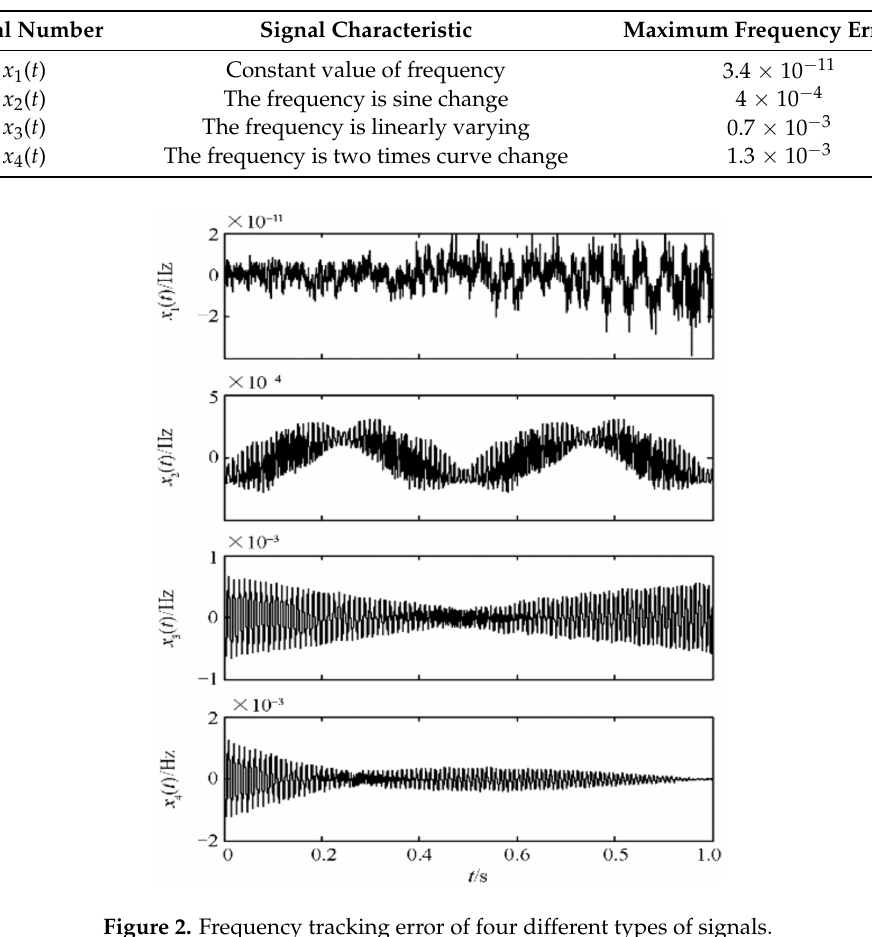
Figure 2. Frequency tracking error of four different types of